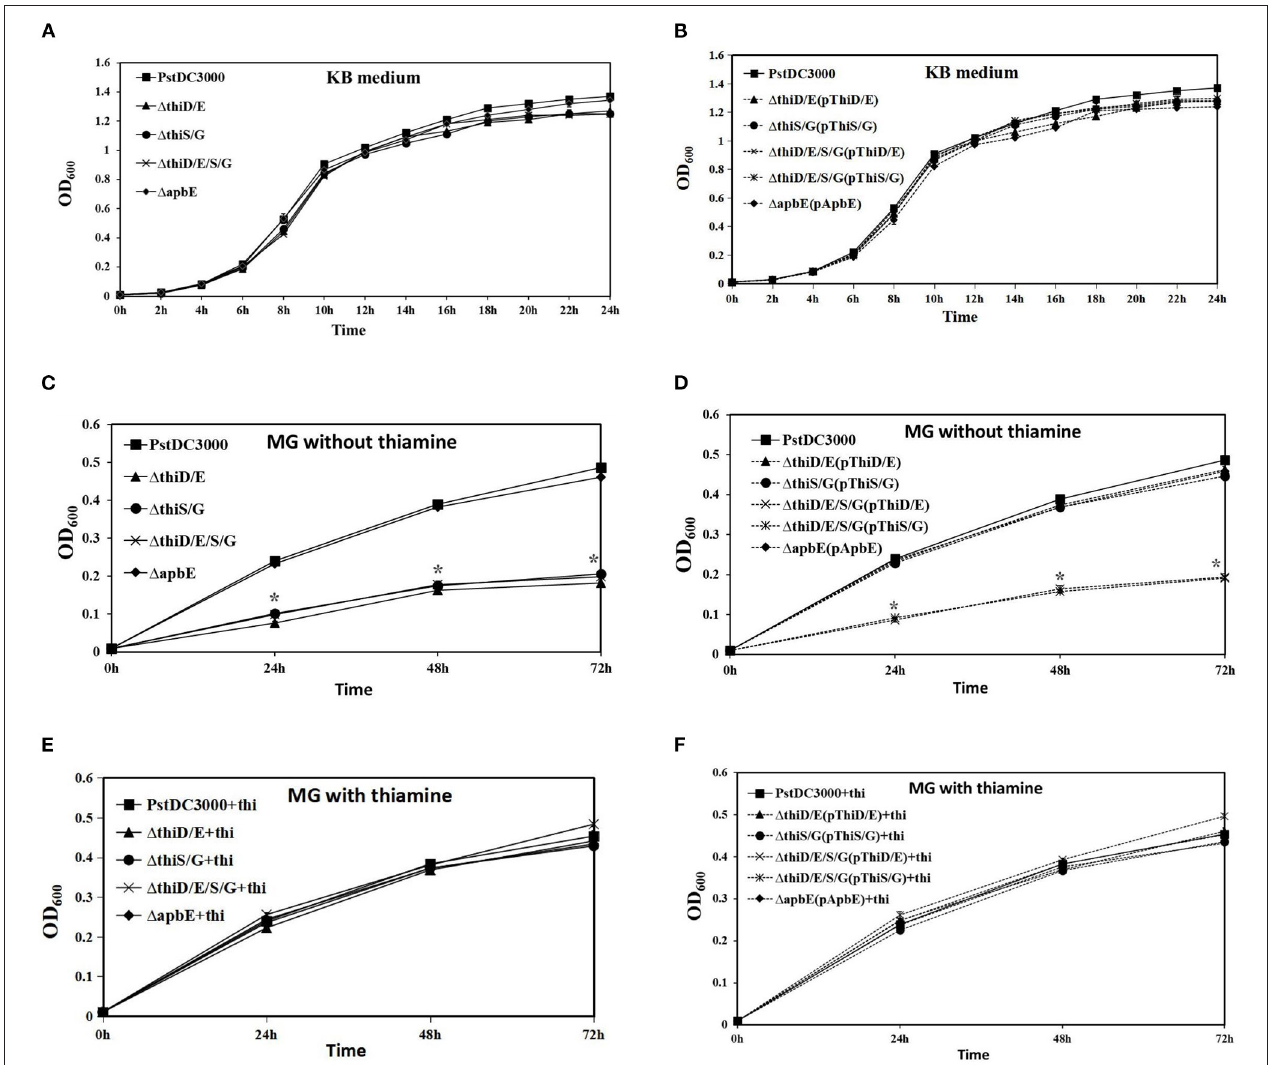
FIGURE 2 | Thiamine-related genes are required for the growth of Pseudomonas syringae pv. tomato DC3000 ( Pst DC3000) in minimum medium. (A) Growth of Pst DC3000 wild type (WT), the thiD/E , thiS/G , thiD/E/S/G , and apbE mutant strains in King’s B medium (KB). (B) Growth of complementation strains in KB. (C) Growth of all the mutant strains in mannitol-glutamate (MG) medium. (D) Growth of complementation strains in MG medium. (E) Growth of all the mutant strains in MG medium with exogenous 100 µ g/ml thiamine. (F) Growth of complementation strains in MG medium with exogenous 100 µ g/ml thiamine. The solid line represents mutant strains; the dashed line represents complementation strains; and the vertical bars represent SDs. “ + thi:” added exogenous 100 µ g/ml thiamine. Experiments were performed in triplicate and repeated three times. Statistical tests were performed at 24, 48, and 72h. Statistically significant differences were determined by one-way ANOVA and P -values were < 0.05 [an asterisk (*) indicates P < 0.05, mutant and complementation strains vs. the WT Pst DC3000].